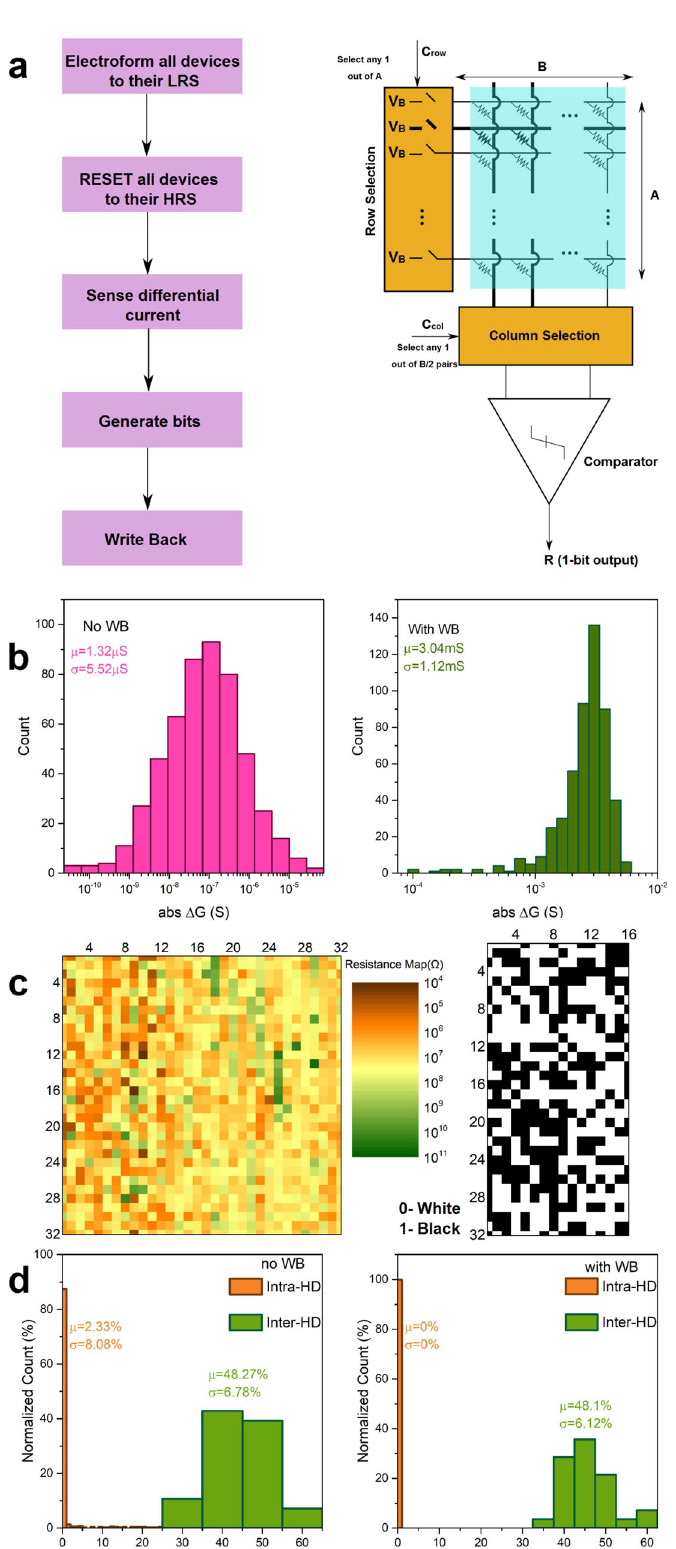
Fig. 3 1-D Halide Perovskite (HP) Weak memristor Physical Unclonable Function (memPUF). a Flowchart of HP memPUF bit generation (left). Circuit architecture of 1-D HP memPUF 32 × 32 crossbars, with differential sensing through a low-offset comparator (right). b Distribution of differential conductance before and after write-back. The magnitude of differential conductance shows a marked increase after write-back (WB) which results in improved reliability. c Analog map of HRS showing high randomness, and digital maps obtained after write-back. d Inter and Intra-HD before and after write-back for temporal changes show a reduction in bit error rate (BER) or intra-HD to 0% after write-back compared to 2.33% before write-back. Large separation between inter and intra-HD after write-back constitutes a good PUF that is identi fi able and